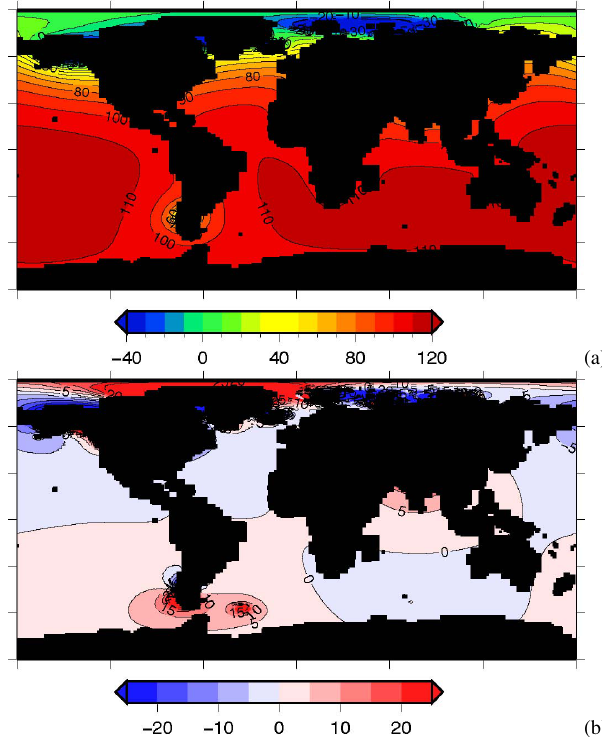
Fig. 10: (a) Local sea-level change (1990–2090) relative to Fig. 10. (a) Local sea-level change (1990–2090) relative to the the ensemble global mean sea-level change (%) (R10, global ensemble global mean sea-level change (%) (R10, global average average 0.149 m). (b) Difference in relative sea-level change 0.149m). (b) Difference in relative sea-level change (%) (R10– (%) (R10–W01).